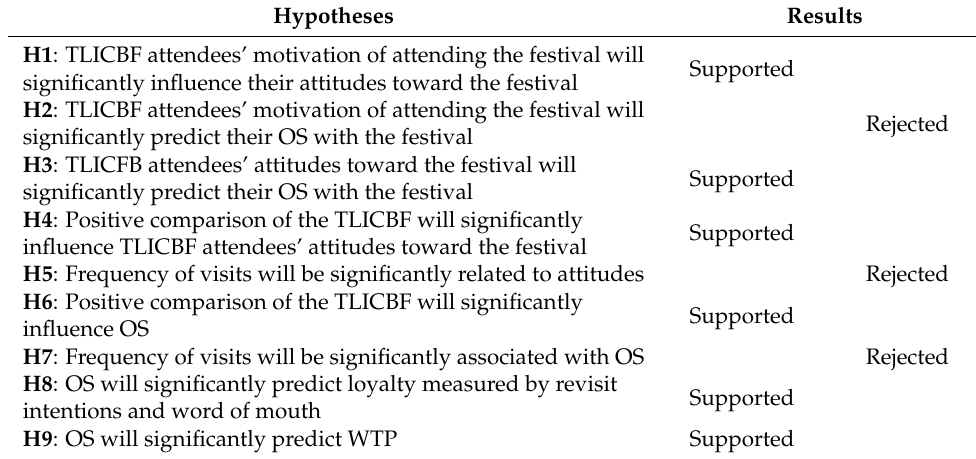
Table 8. Results of hypothesis tests.